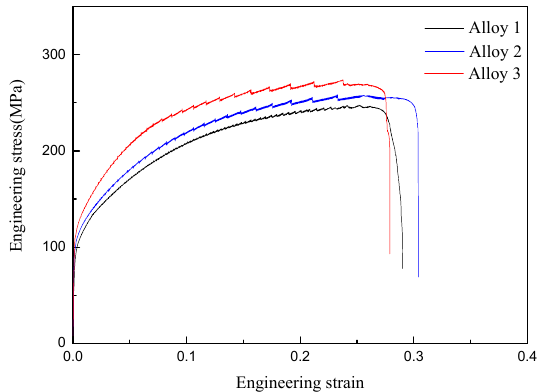
Figure 7. The engineering stress-strain curves of the as-cast Al-Mg alloys.